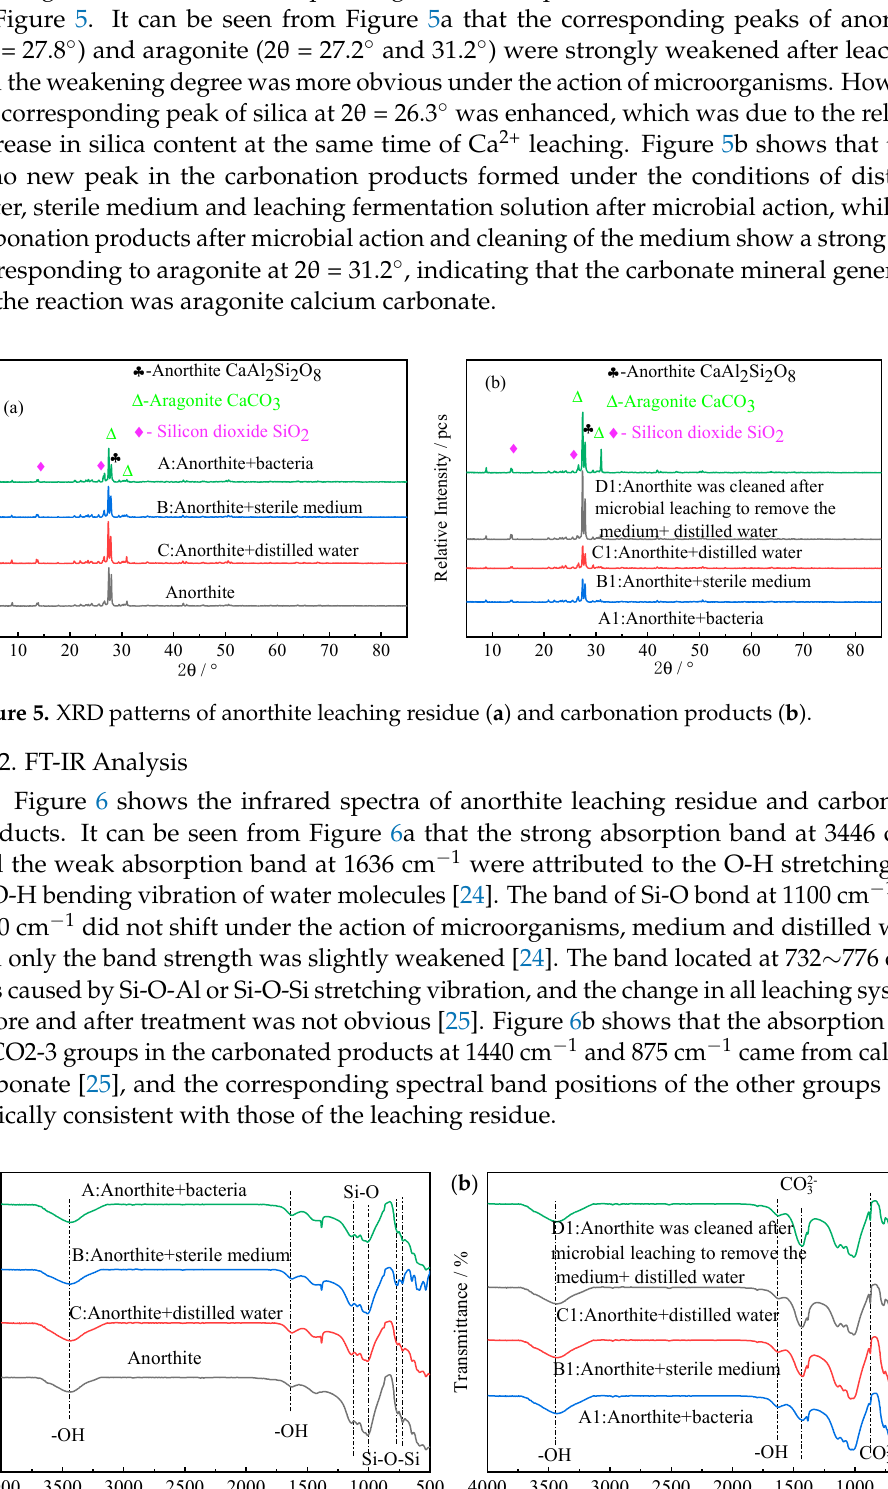
Figure 4. Carbonation conversion with pretreatment time for different fermentation systems.